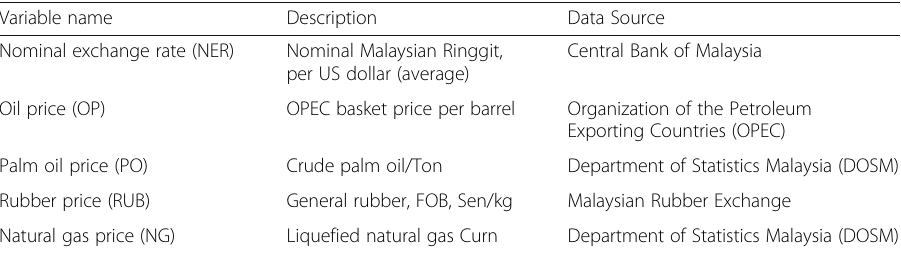
Table 1 Data description and data